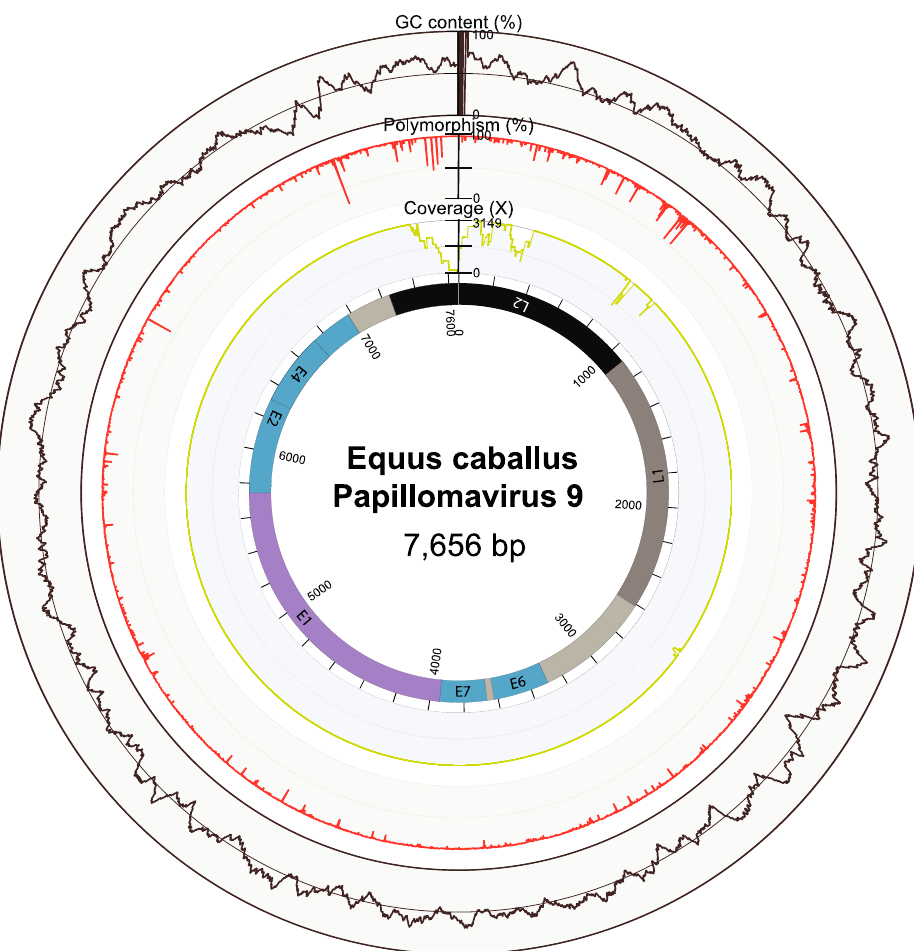
Figure 1. Genome organization of Equus caballus papillomavirus 9 (EcPV9). The external circles of the metadata ring indicate the percentage GC content (brown), percentage nucleotide polymorphism (red), and read coverage (yellow). The inner gray circle represents the genome, with colored regions showing the predicted open reading frames (ORFs).